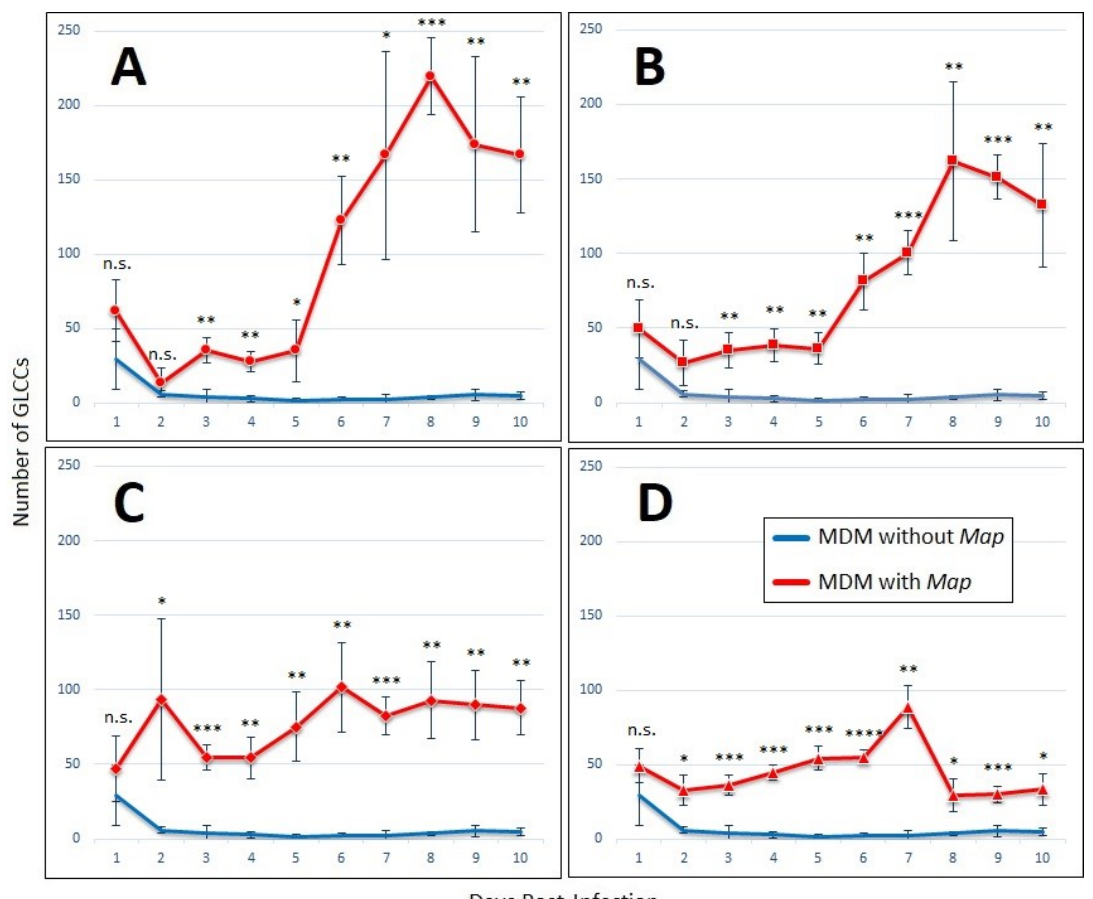
Figure 2. GLCCs form in the presence of lymphocyte-specific signaling factors alone. Graphs of GLCC formation over ten-day experiment with MDMs cultured without non-adherent PBMCs, with conditioned medium from Map -exposed lymphocytes, after exposure to Map at an MOI of ( A ) 1:4, ( B ) 1:2, ( C ) 1:1, or ( D ) 2:1. The bars are standard deviation. * p < 0.05; ** p < 0.01; *** p < 0.001; **** p < 0.0001; n.s. = not significant by student’s t-test (n = 4).